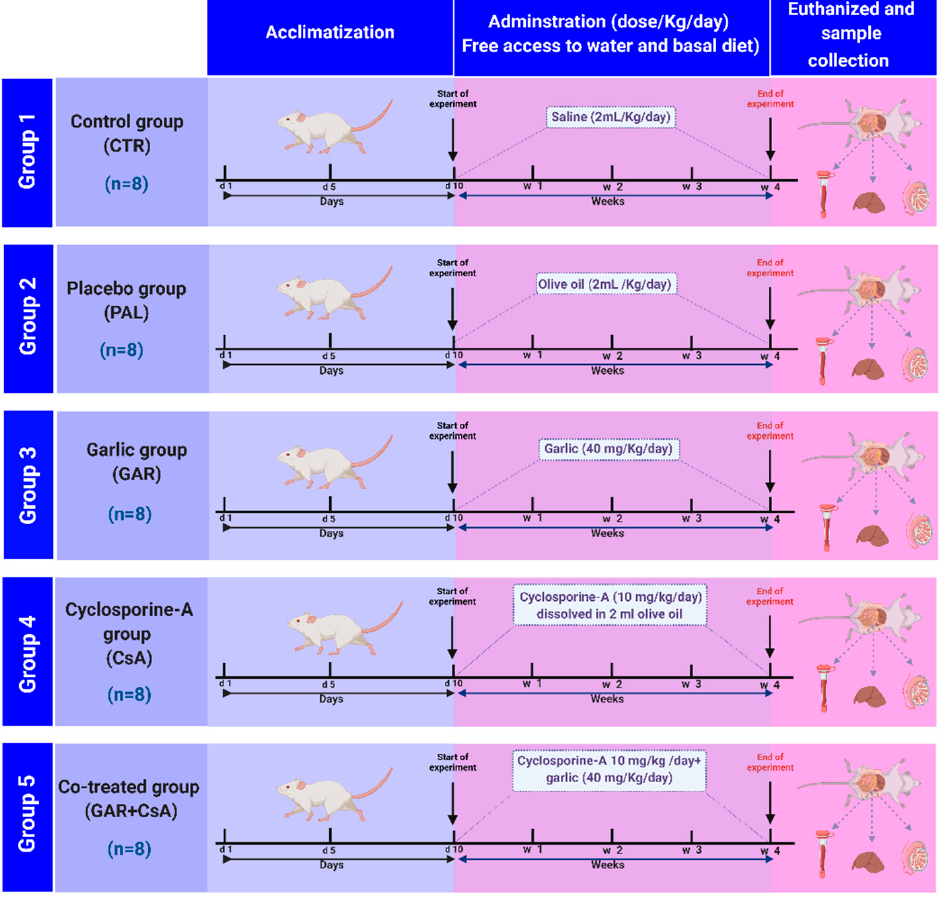
Figure 1. Experimental design.